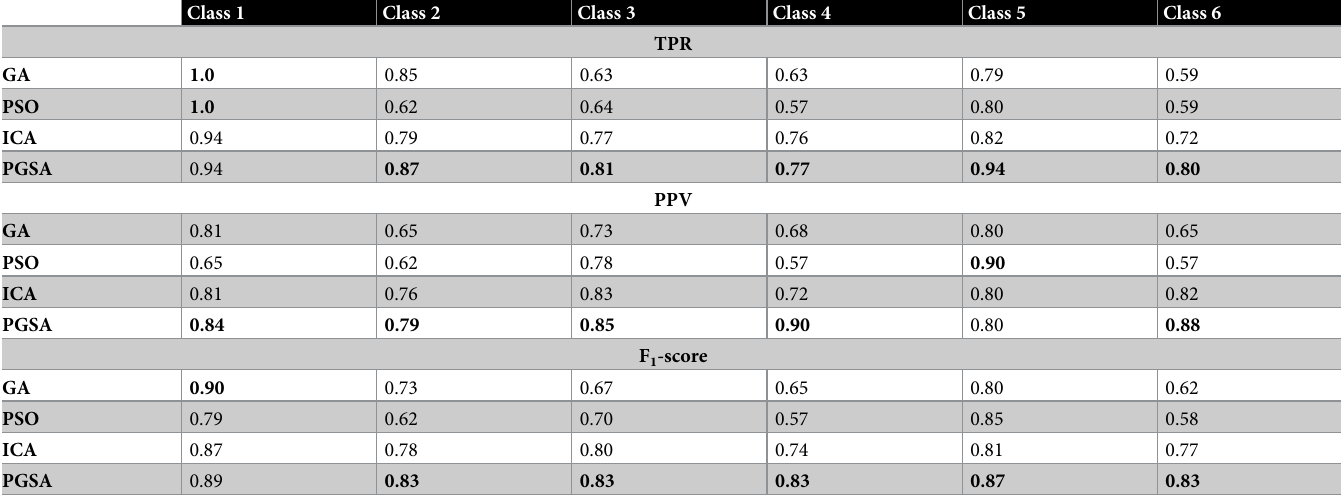
Table 3. Five-fold cross-validated TPR, PPV, and F 1 -score of different algorithms. The best result for each class has been